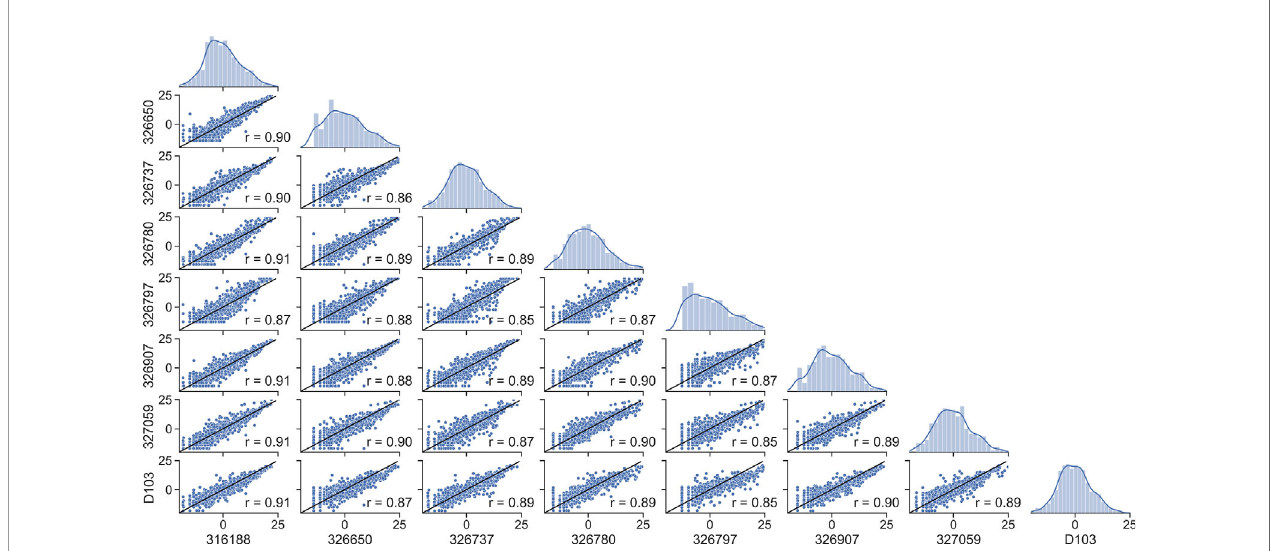
FIGURE 2 | Framework scores arerepeatable between individuals. Distributionsandcorrelationsof patient-speci fi c PSSM scores for the V H 3-23*01 germline. Alphanumeric characters on the y- and x-axes represent de-identi fi ed